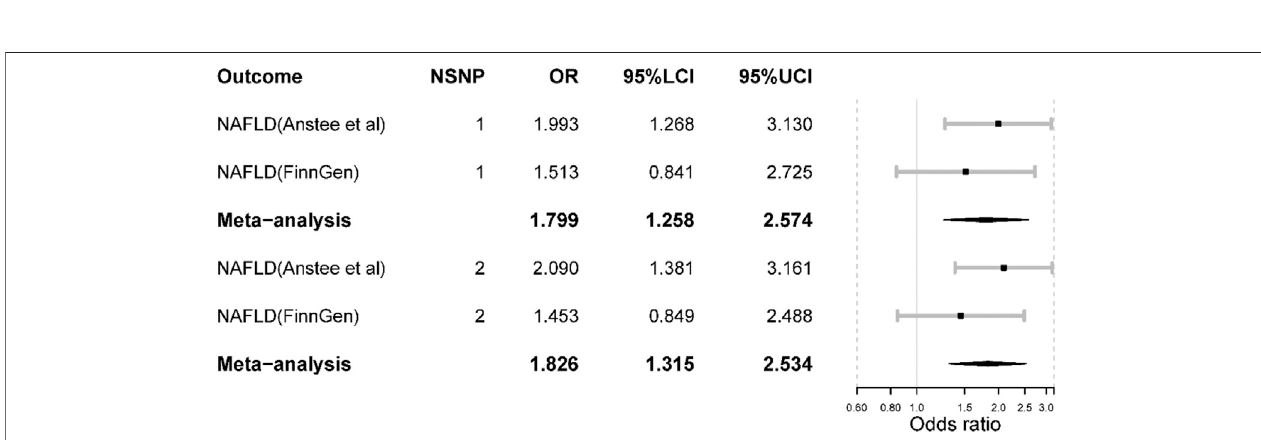
FIGURE 3 | The main Mendelian randomization results. NSNP is the number of SNPs used in analysis and the SNP rs2228145 was used if NSNP = 1. The SNP rs2228145 and rs12048091 were used if NSNP = 2. OR is the odds ratio. 95% LCI is the lower limit of 95% con fi dence interval while 97%UCI is the upper limit of 95% con fi dence